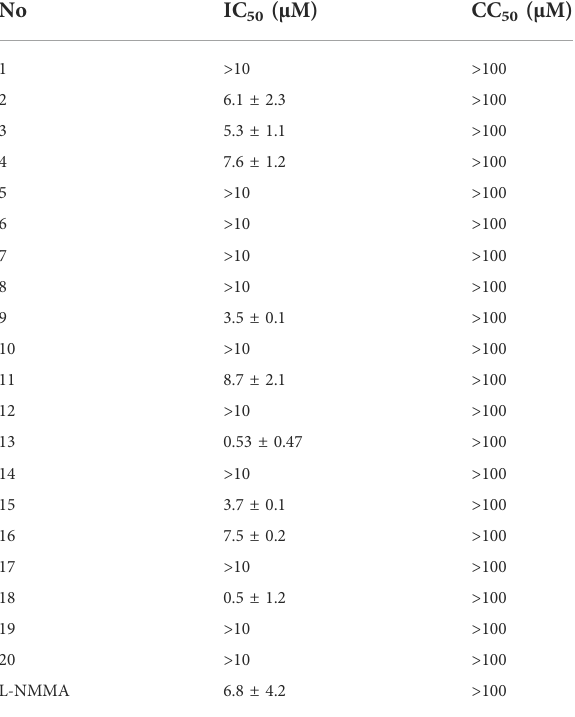
TABLE 1 Inhibitory effects of 1 – 20 against NO production in LPS- induced BV-2 cells. No IC